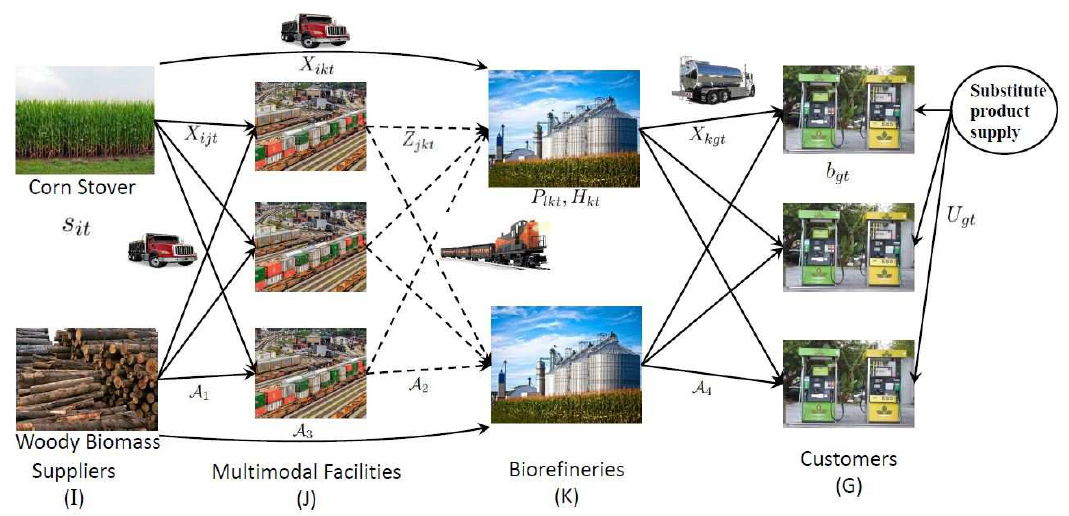
Figure 2. Network representation of biofuel supply